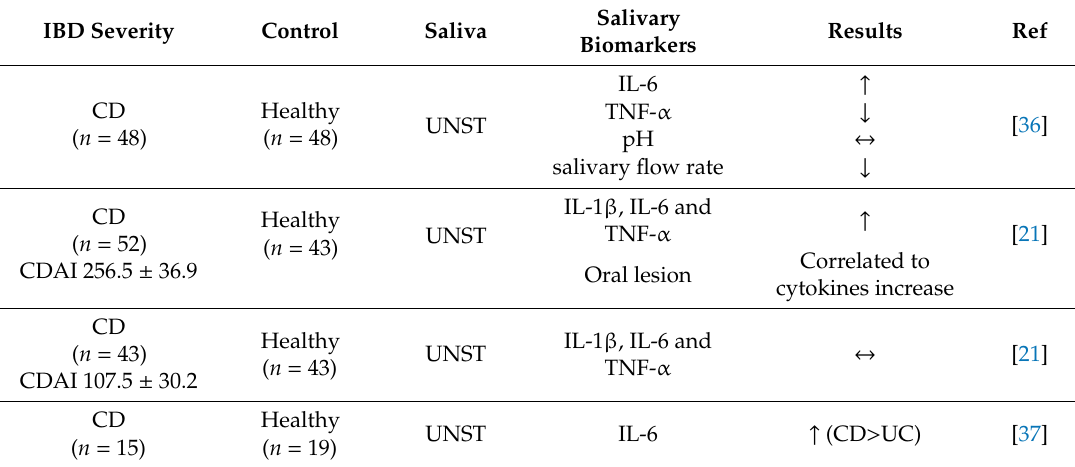
Table 1. Cytokine profile in the saliva of patients with inflammatory bowel disease